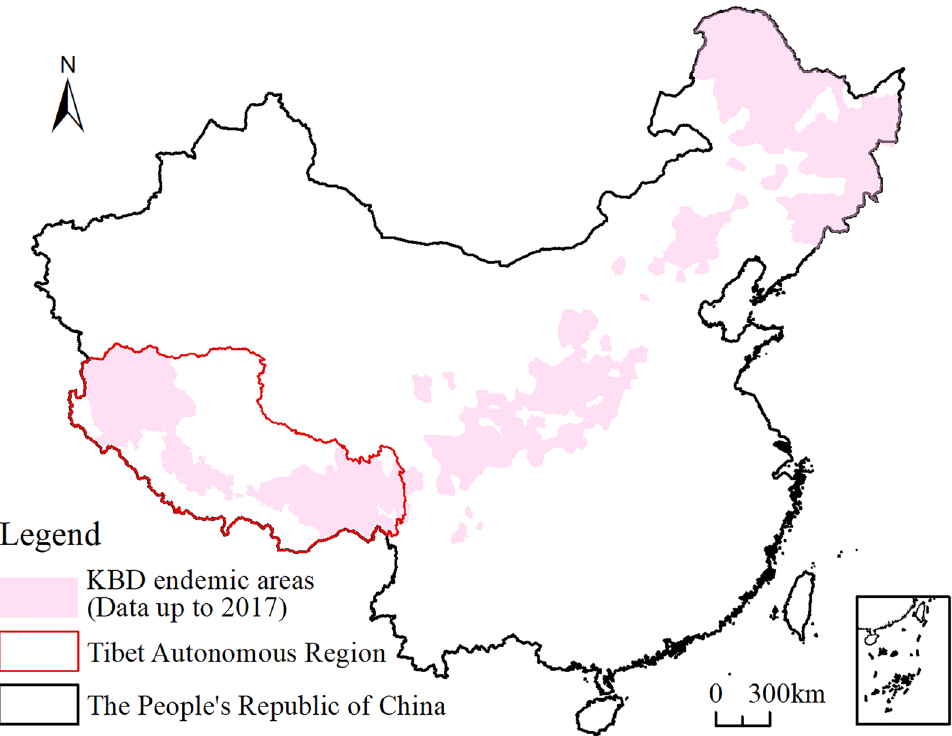
Figure 1. Distribution of sites that have been affected by KBD in China (data cited from Dinh et al. 28 ; this figure was created with ArcGIS 10.8, URL: https:// www. esri. com/ en- us/ arcgis/ produ cts/